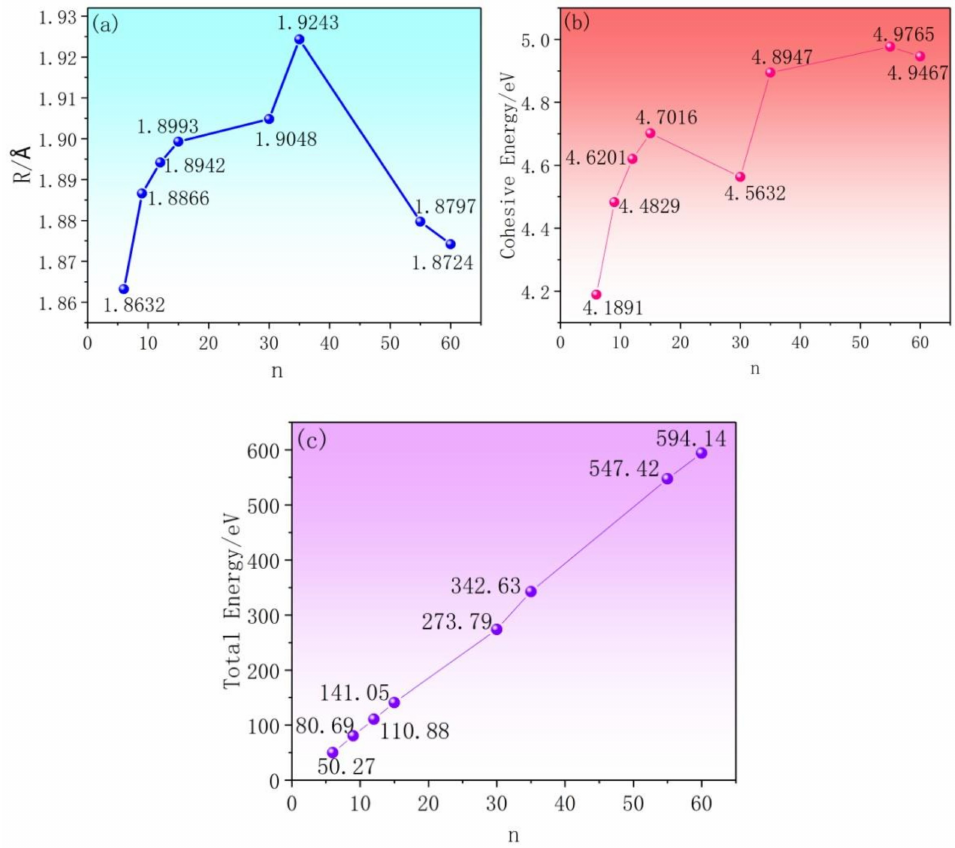
Figure 3. ( a ) The average bond lengths, ( b ) the cohesive energies and ( c ) the total energies of the (AlN) n (n = 6,9,12,15,30,35,55,60)